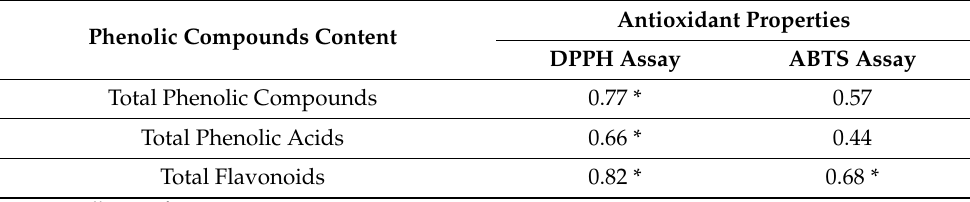
Table 3. Pearson’s correlation coefficients (r) between antioxidant properties and the content of phenolic compounds of studied gingerbread cookies. Antioxidant Properties Phenolic Compounds Content DPPH Assay ABTS Assay Total Phenolic Compounds 0.77 * 0.57 Total Phenolic Acids 0.66 * 0.44 Total Flavonoids 0.82 * 0.68